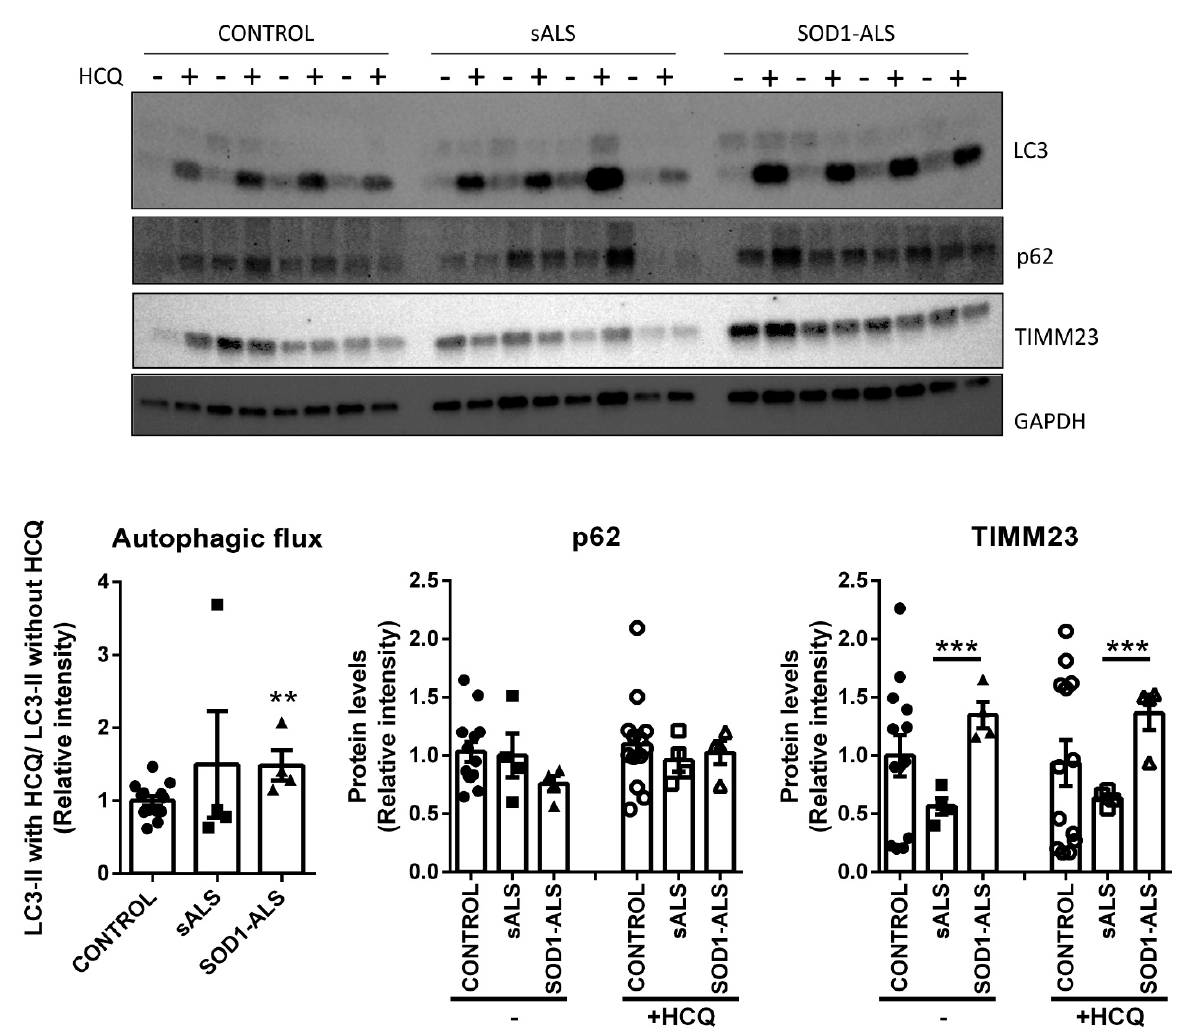
Figure 6. Increased autophagy flux in SOD1 -ALS lymphoblasts. Densitometric quantification of representative blots normalized for GAPDH. Immunoblot analysis in whole control, sALS and SOD1 -ALS cell lysates of protein levels of LC3, p62, and TIMM23. Dots indicate the mean of n = 13 (control) n = 4 (sALS) and n = 4 ( SOD1 -ALS) samples ± SEM. Asterisks denote significant differences ** p < 0.01 and *** p < 0.001.